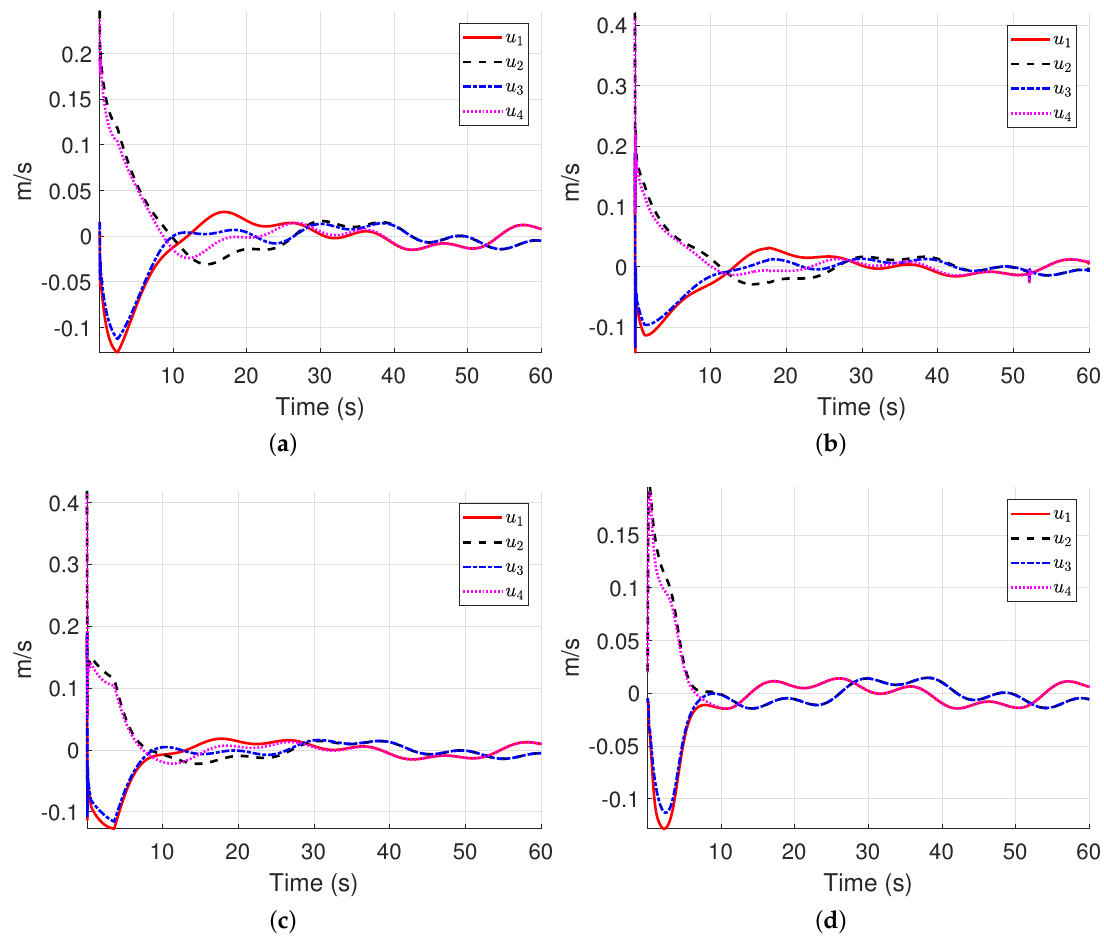
Figure 13. Velocity control signal results for the rose curve trajectory. ( a ) Velocity control signal of PID. ( b ) Velocity control signal of BP-PIDNN. ( c ) Velocity control signal of HR-PIDNN. ( d ) Velocity control signal of EKF-SNPID. Table 2. Simulation results for the rose curve trajectory. The best results are highlighted in